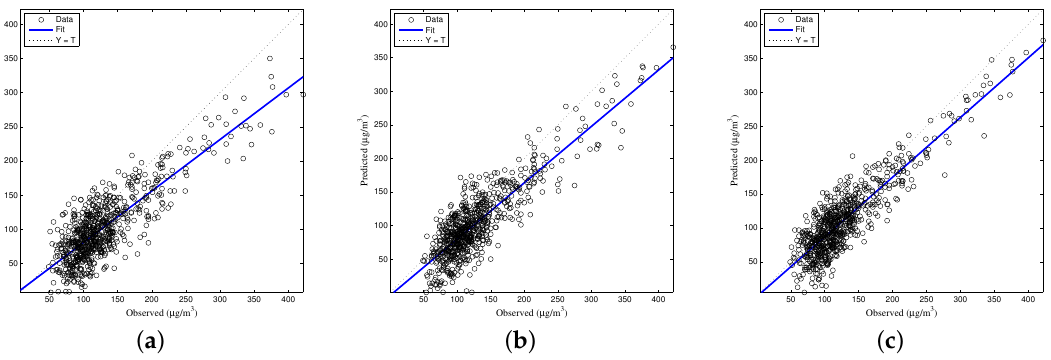
Figure 4. Comparison of prediction results among MLR, FFANN-BP, and ELM. NO x predictions ( a ) MLR; ( b ) FFANN-BP; ( c )